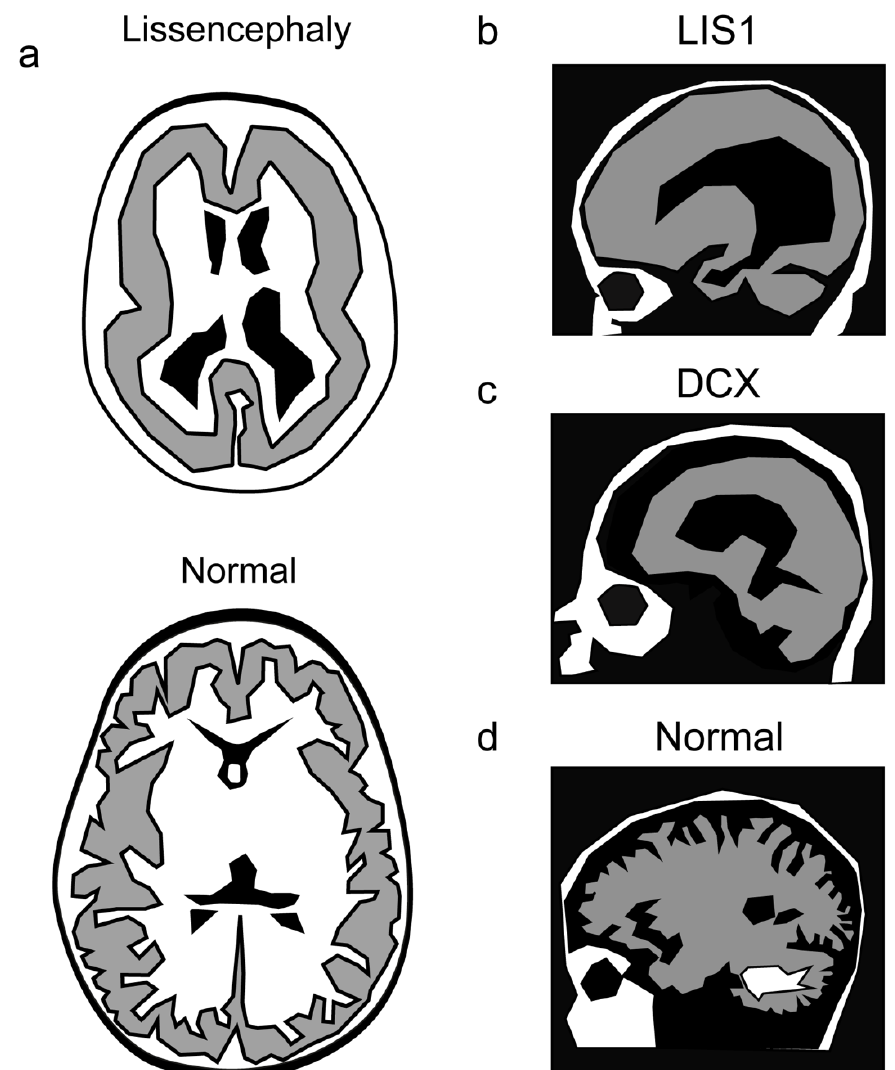
Figure 4. Lissencephaly manifests with a reduction in the normal brain folds. ( a ) A schematic of a lissencephalic and a normal brain. ( b – d ) Mutations in LIS1 result in a more severe phenotype in the caudal part of the brain ( b ), whereas mutations in DCX affect more the rostral part of the brain ( c ), as shown in comparison with the normal brain ( d ).